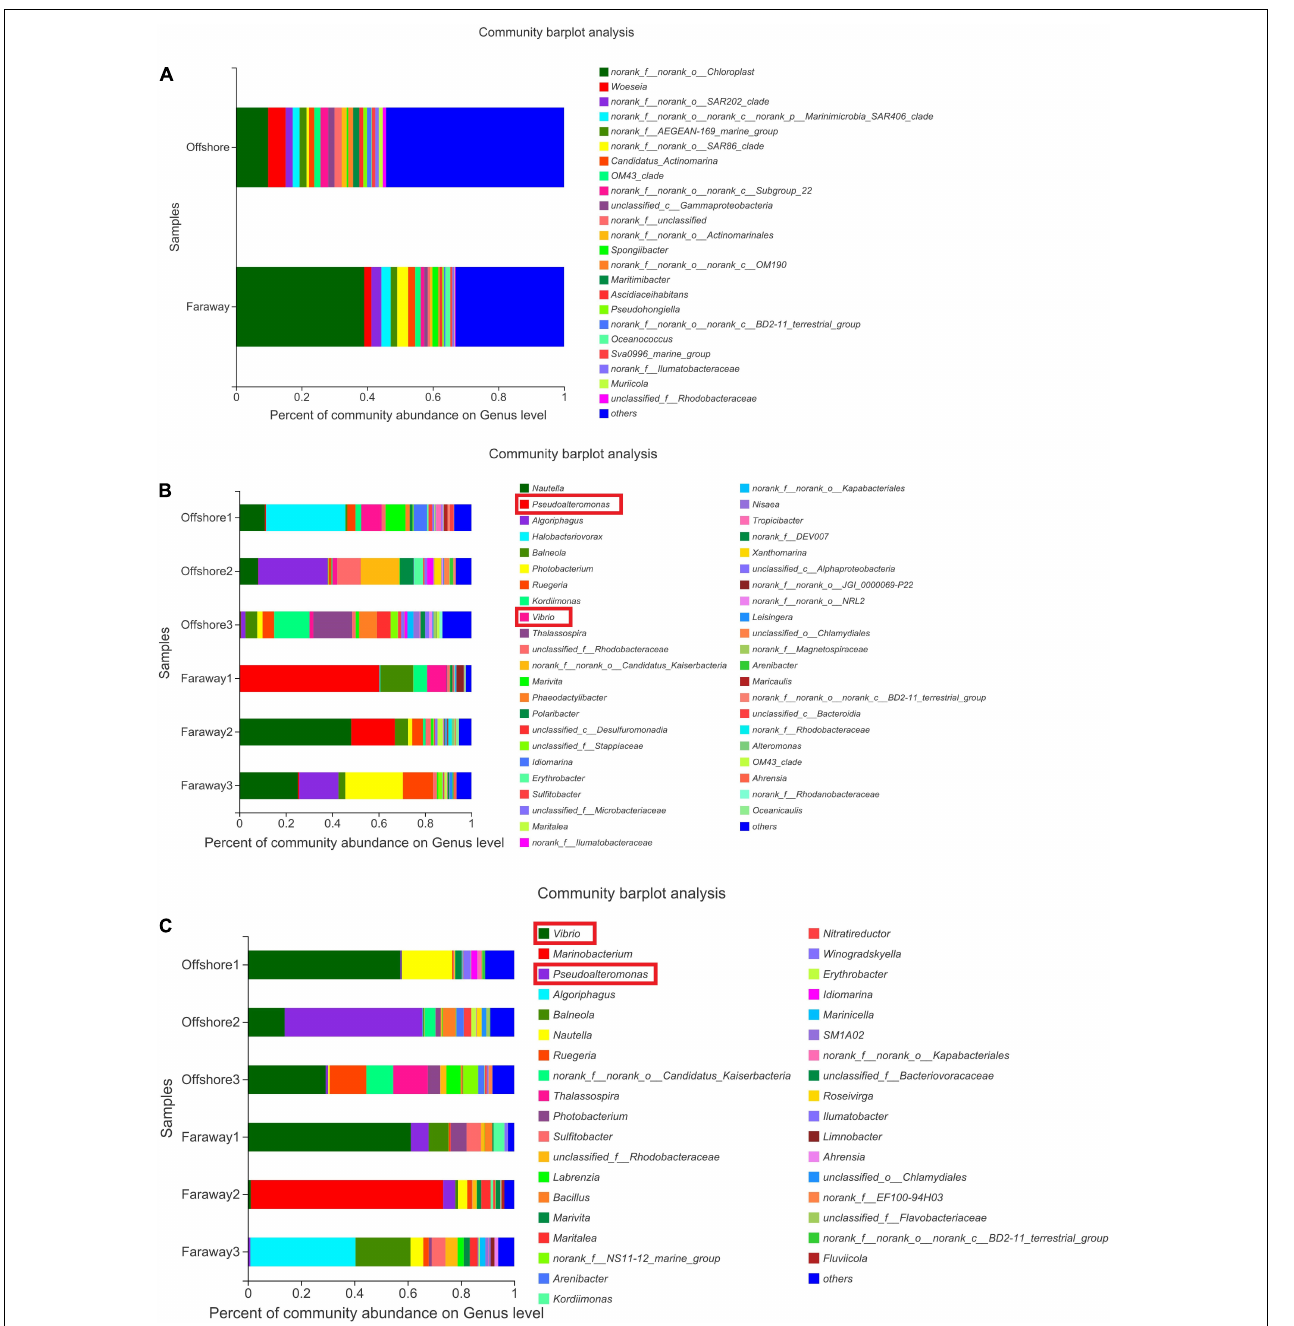
FIGURE 9 | Microbial community structure of the initial day (A) , 15 days (B) , and 30 days (C) on genus level (Offshore represents the distance of 0.2 km from shore. Faraway represents the distance of 5 km from